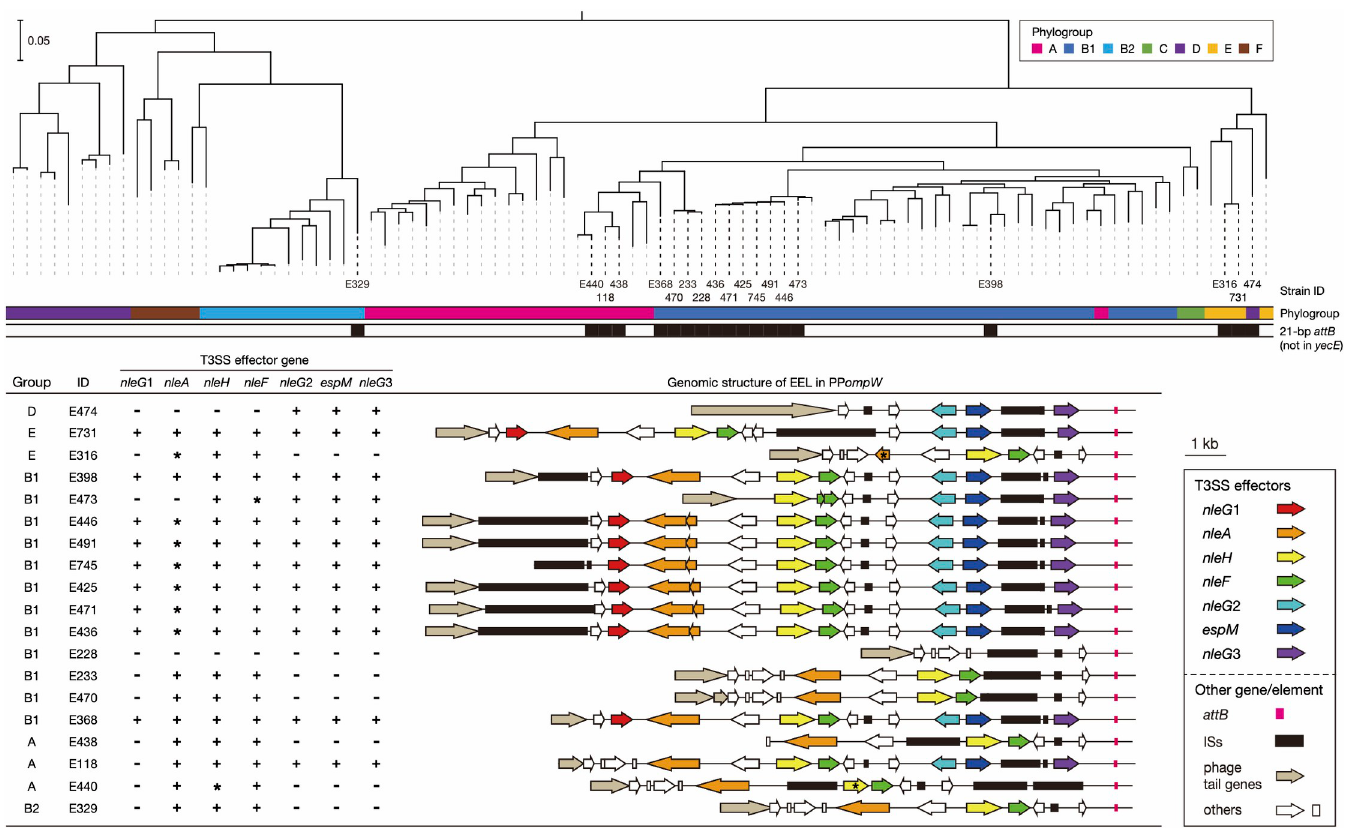
Fig 3. Phylogenetic positions of E . coli strains carrying PP ompW and the genome structures of their EELs associated with 21-bp attB sequence. In the upper panel, an ML tree of 92 complete genomes of E . coli strains that carry PP ompW is shown. The tree was constructed based on 109,927 SNP sites in 2,642 core genes and rooted by cryptic Escherichia clade I strain TW15838 (No. AEKA01000000) used as an outlier. Along with the tree, strain IDs used in this paper (see S5 Table for more details), phylogroups, and the presence (colored) or absence (open) of 21-bp attB sequence in each strain are indicated. The bar indicates the mean number of nucleotide substitutions per site. In the lower panel, the repertoires of T3SS effector genes that were encoded by the effector exchangeable loci (EELs) in the PP ompW s containing the 21-bp attB sequence are shown. The genomic structures of EELs are drawn to scale. All effector genes were aligned using BLASTN, and orthologous genes (sequence identity; > 90%, coverage; > 90%) are indicated by the same color. Genes with over 90% identity but less than 90% coverage and those containing indels and nonsense mutations in the sequence alignment to intact genes are indicated by